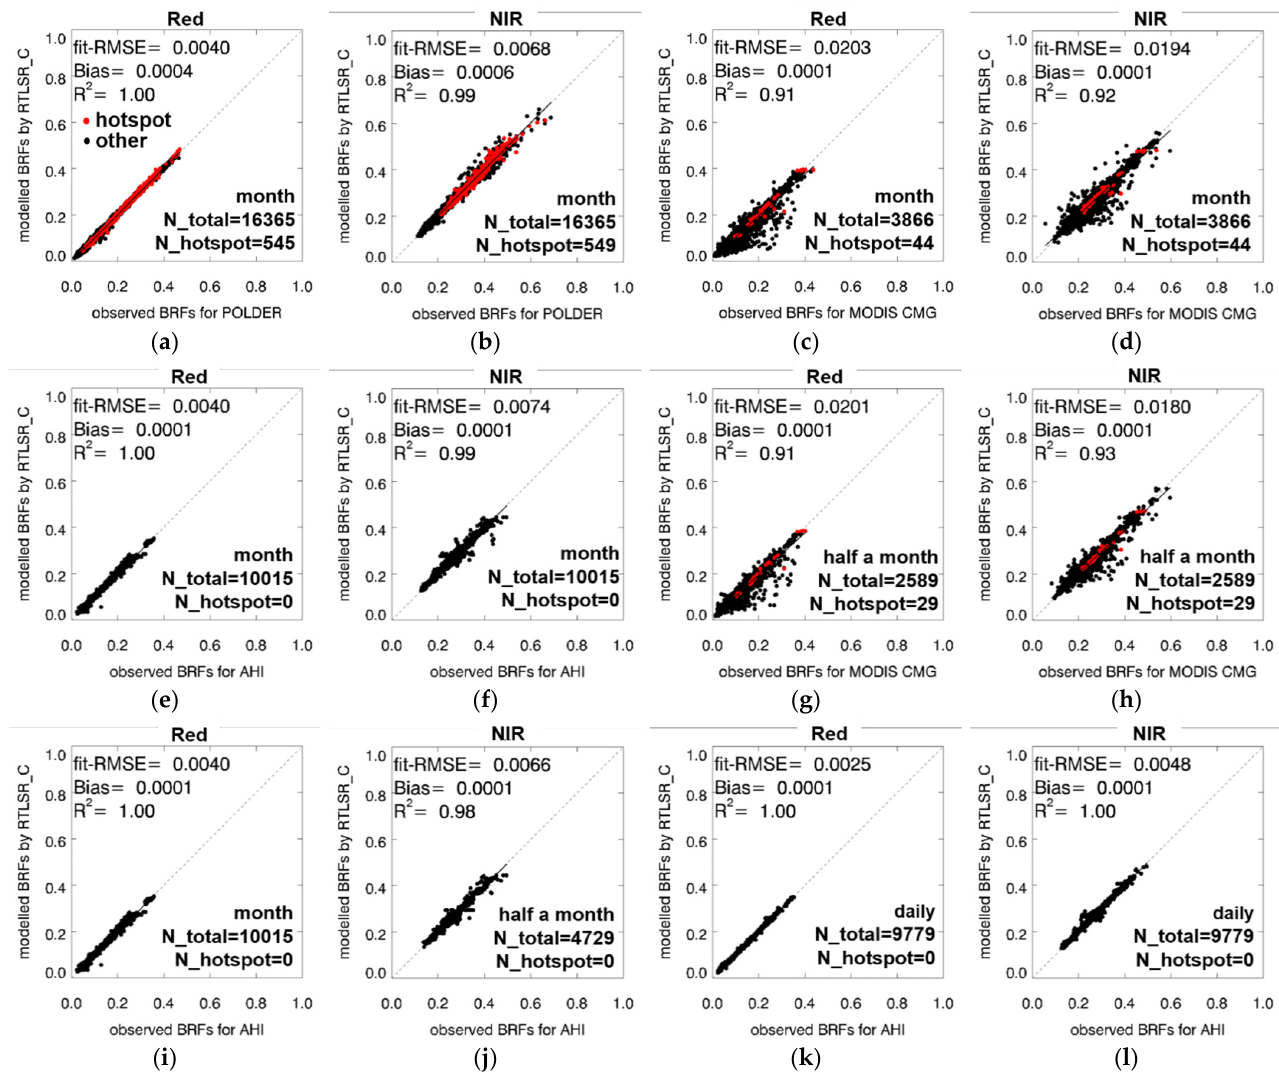
Figure 8. Comparisons of reflectances between the observed and RTLSR_C-fitted values from AHI- and MODIS CMG-accumulated observations during a whole month, half a month, and a day. The red dots represent data near the hotspot direction, and the black dots are data at the remaining geometries. The sensors, bands, and time spans are labelled in each plot. ( a – f ) refer to the results at the month scale for the three sensors in the red and NIR bands, and ( g – j ) refer to those for AHI and MODIS at the half-month scale. ( k , l ) refer to the results for AHI at daily